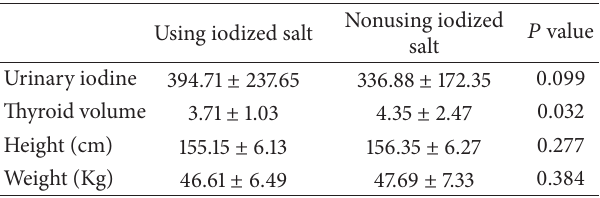
Table 3: Urinary iodine and thyroid volume according to consum- ing ionized